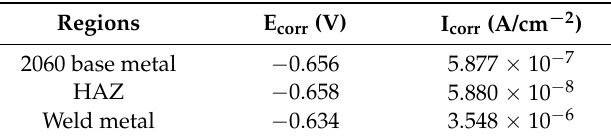
Figure 8. Polarization curves of different regions of the weld in 3.5% NaCl solution. Table 3. Corrosion potential Ecor and corrosion current density Icor of different regions of the weld during electrochemical corrosion in in 3.5% NaCl solution.